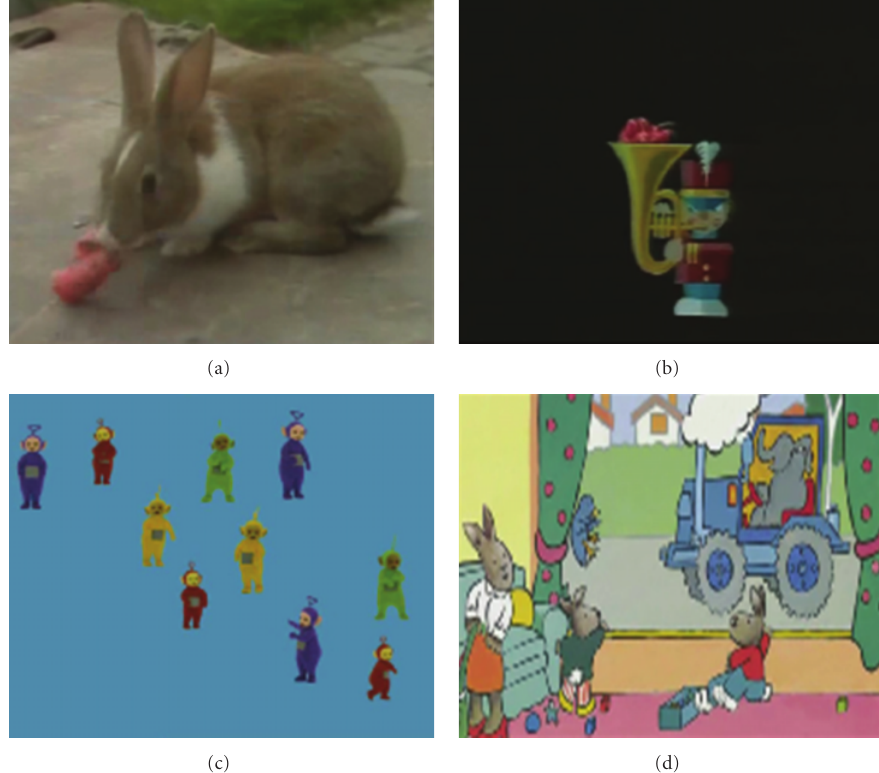
Figure 1: Clockwise, starting upper left: Puzzle Rabbit movie, Trumpet movie, Grandma Rabbit movie, and Teletubbies movie.